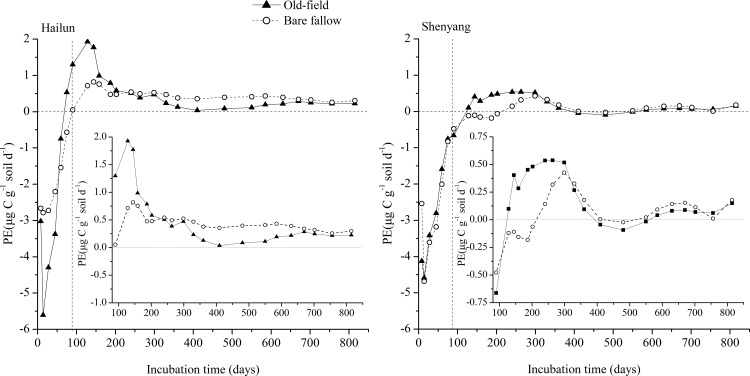
PE (priming effects, instantaneous rate, μg C g-1 soil d-1) of added maize leaves on SOC decomposition of soils from Hailun (left) and Shenyang (right) station.The inserts show the priming effect starting at day-90 when most treatments started to show a positive priming effect. The running average was obtained using Adjacent-Average method (OriginPro 8.5).